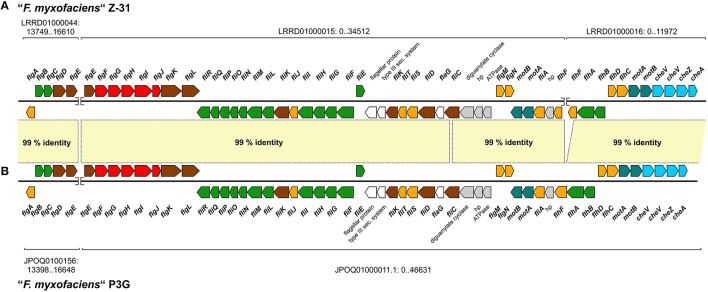
Homologous gene clusters in both “F. myxofaciens” strains predicted to encode proteins involved in the formation of flagella and in chemotaxis. The gene cluster was found to be distributed over three contigs in in “F. myxofaciens” Z-31 (A) and over two contigs in “F. myxofaciens” P3G (B). Nucleotide accession numbers of the contigs containing the flagella gene cluster and the location of the gene cluster on these contigs are given. Gaps between contigs are indicated by a break of the DNA strand. Genes are colored with respect to the predicted function of their product: flagellum motor, turquoise; flagellum inner membrane structures (basal body and secretion apparatus), green; flagellum outer membrane components, red; flagellum extracellular components (hook and filament), brown; regulation of flagella formation, orange; chemotaxis, light blue; unknown function but associated with flagella, white; not involved in flagella formation, gray. Nucleotide sequence identities between both gene clusters are based on a genome comparison of both “F. myxofaciens” strains by blastn and visualization using ACT (light yellow, Carver et al., 2005).